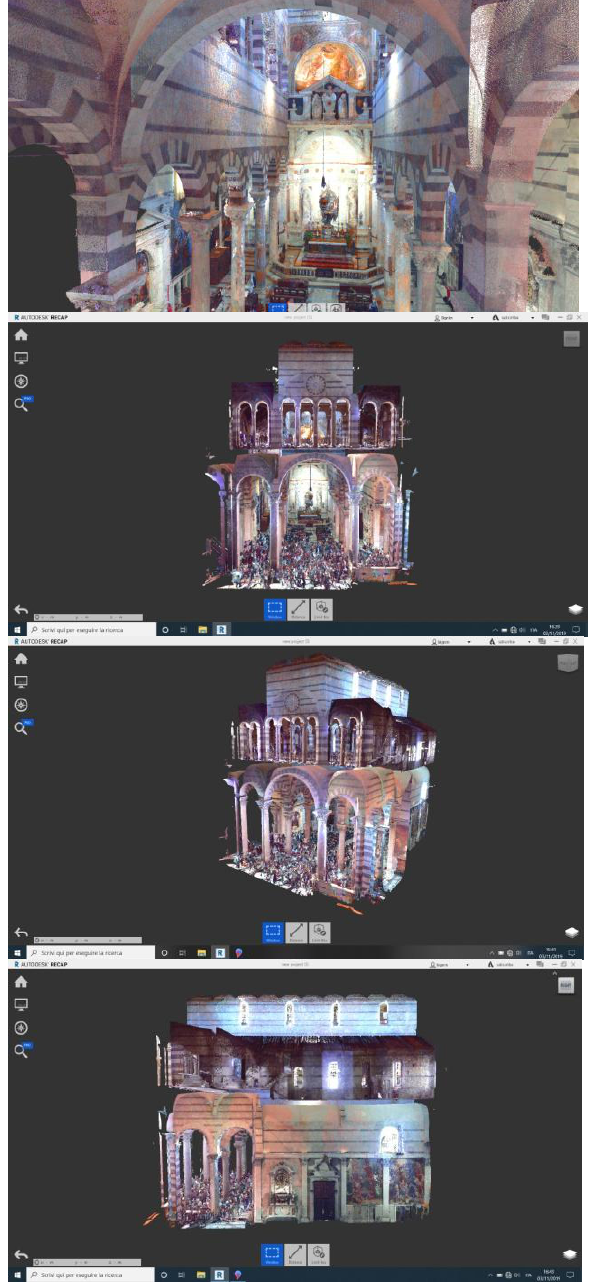
Figure 3. Views of the Transept obtained from the point cloud.